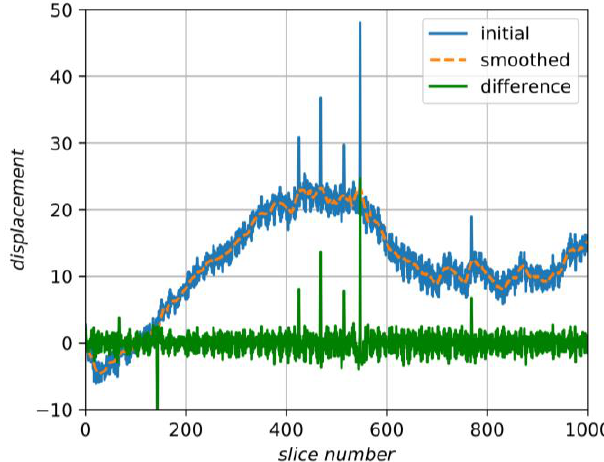
( b ) Figure 6. The side view of the synthetic image: ( a ) GT; ( b ) after displacement of slices. 4. Proposed Method For simplicity, we start an explanation of our method from the case of displacements only; after that, we generalize the technique to arbitrary affine distortions. We consider displacements produced by alignment algorithms as a signal depending on the slice number and containing two components. The first component corresponds to fluctuations in the data due to various random processes in the device. We assume that since these shifts are random, they correspond to a high frequency in the